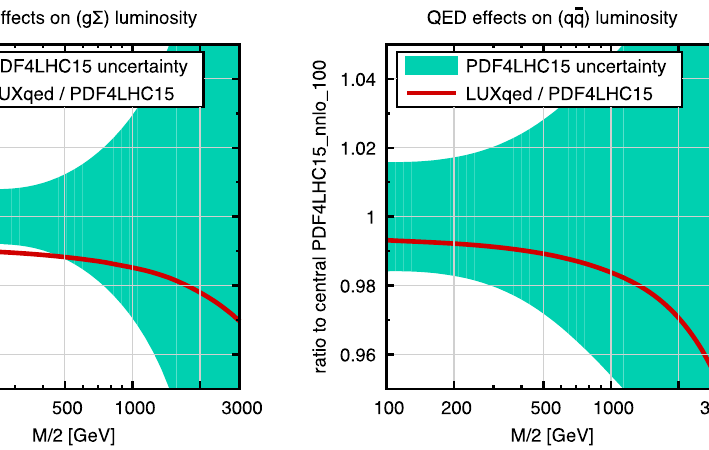
Fig. 13 Impact of QED effects on the two partonic luminosities ( g (cid:23) and q ¯ q ) that contribute dominantly to the Z + jet cross section. The luminosity for producing a system of mass M from two fla- vors a and b is defined as L ab = and the g (cid:23) luminosity corresponds to 2 q ¯ q luminosity corresponds to 2